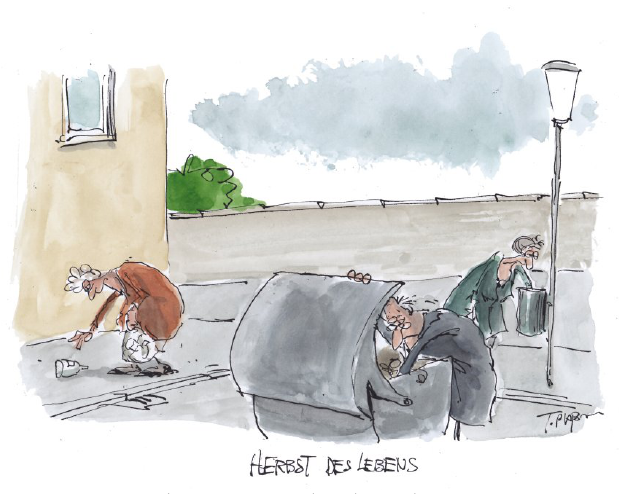
Figure 1 – «Herbst des Lebens»